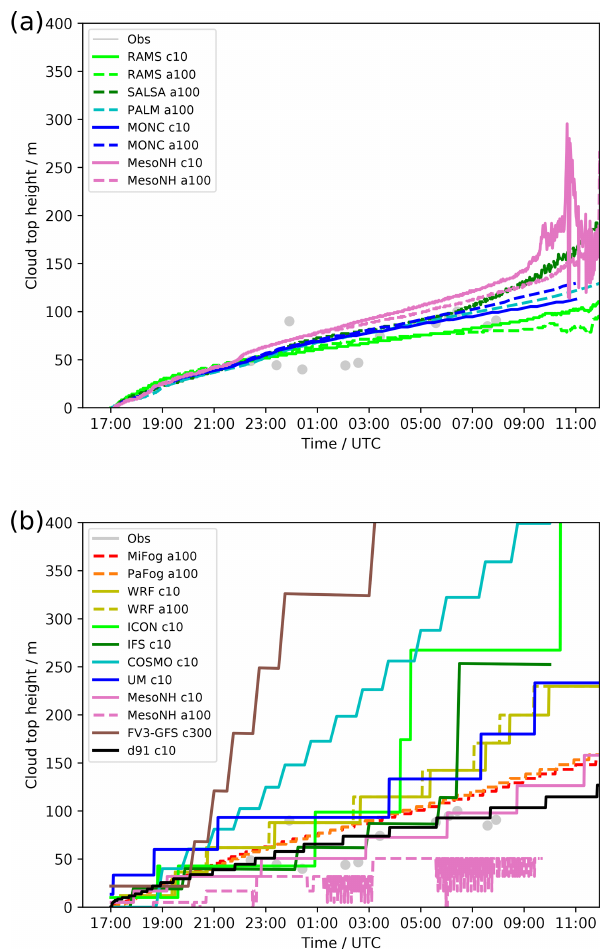
Figure 7. Fog top height observed and modelled by (a) low aerosol/CDNC LES and (b) low aerosol/CDNC